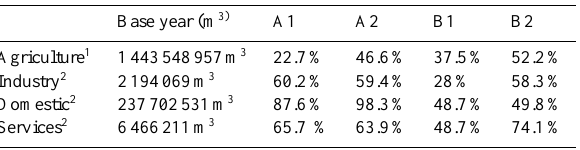
Table 4. Water consumption by sector in the project study area Adaptaclima-EPAL in the base year (2000) and scenarios (percent of base year values) for